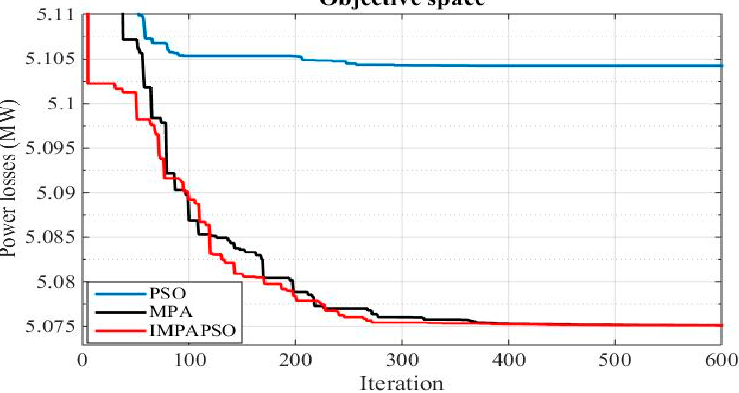
Figure 3. Convergence of PSO, MPA, and IMPAPSO in the first case of the IEEE 30-bus system. Table 1. IEEE 30-bus system’s first case objective performance.